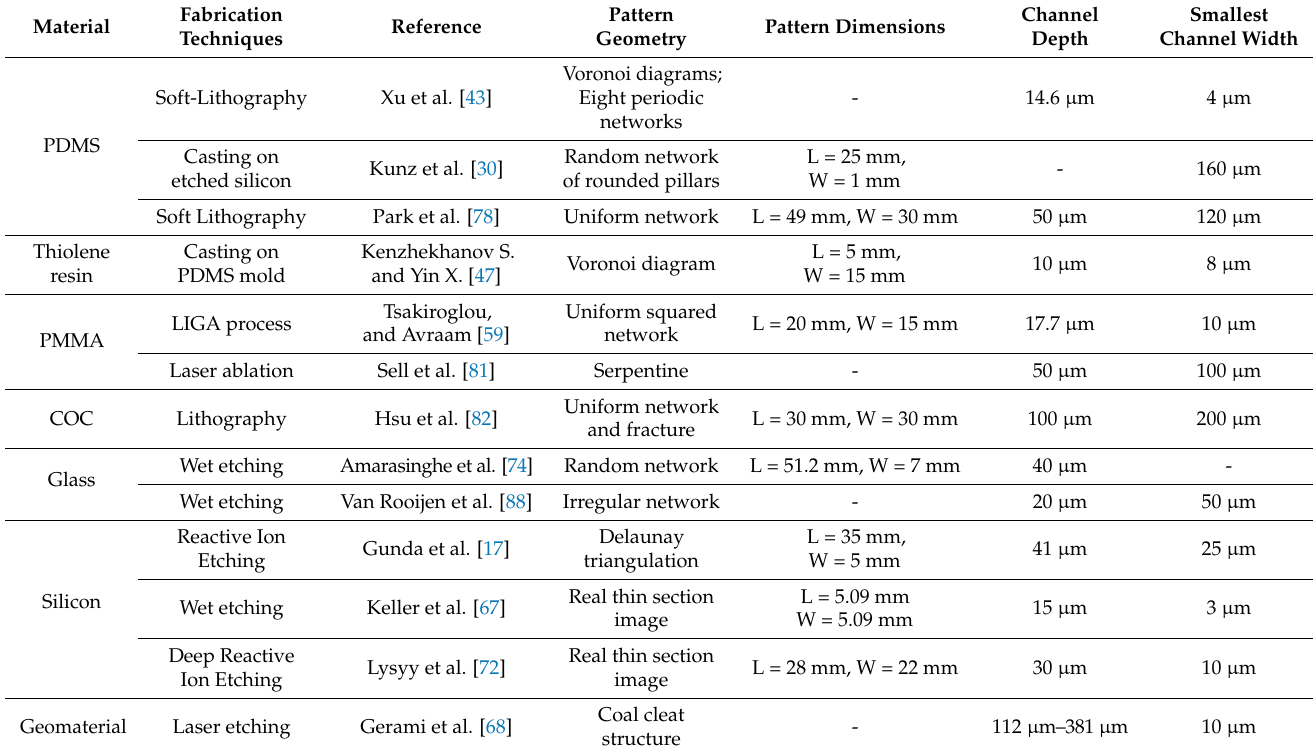
Table 1. Materials and geometrical information of significant works considered in this review.